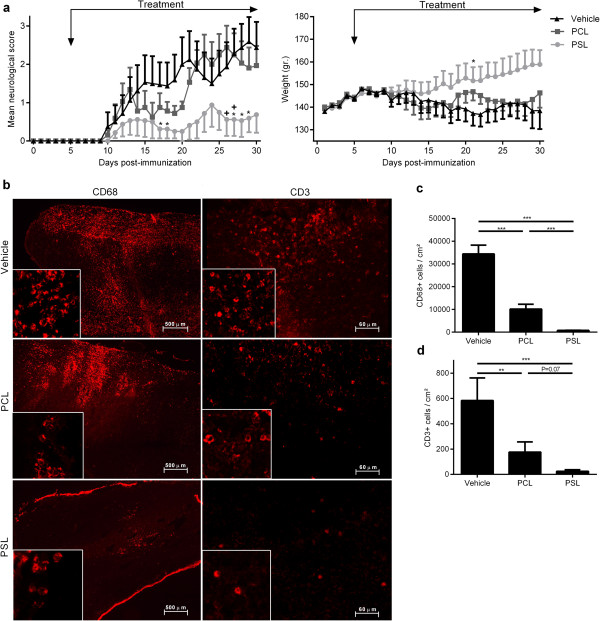
Intravenously injected PSLs reduce CNS infiltration of immune cells and ameliorate EAE. (a) MOG-immunized animals were treated daily with PBS (n=8; black), 5 mg/kg PCLs (n=8; dark grey) or 5 mg/kg PSLs (n=8; light grey) starting from day 5. Neurological score and weight were assessed daily. Data represent the mean ± SEM. *P < 0.05 (vehicle vs PSL), +P < 0.05 (PCL vs. PSL). (b) Spinal cord tissue was isolated 30 dpi and stained with CD3 (20× magnification) and CD68 (4× magnification). One representative image is shown. (c,d) Quantification of T cell and macrophage infiltration in spinal cord tissue 30 dpi. Nine cryosections, covering the complete length of the spinal cord, were stained with CD68 (c) and CD3 (d). A 4× magnification was used to determine the amount of immune cell infiltration. Data represent the mean ± SEM of 4 animals.